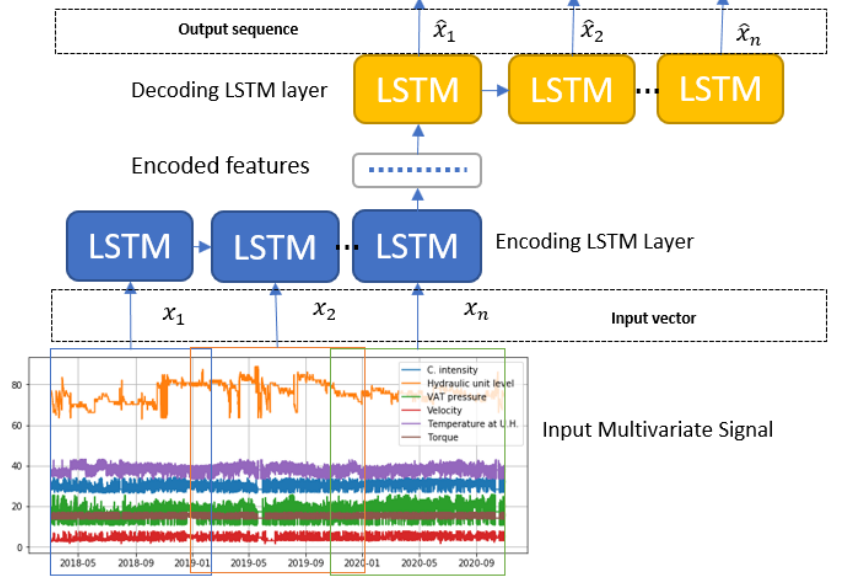
Figure 5. Model summary of one of the LSTM networks used. The model receives a window of n samples of each variable and predicts the value of those variables as predicted 30 days ahead.